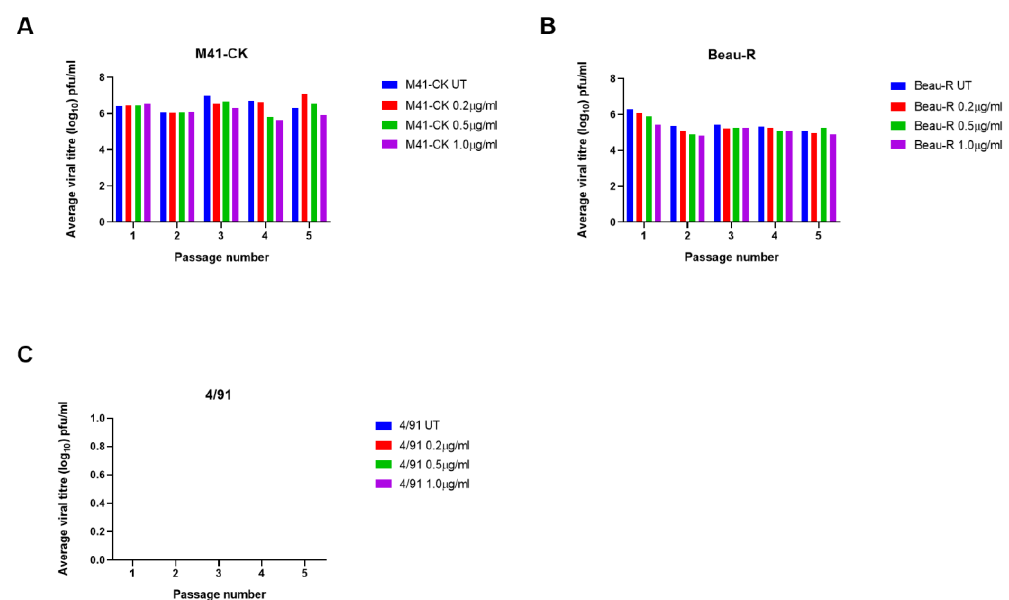
Figure 6. IBV replication is not affected by trypsin cleavage in CK cells. Three strains of IBV were passaged in the presence of TPCK-treated trypsin at three concentrations, 0.2, 0.5 and 1.0 µg/mL, alongside untreated (UT) samples of each strain. Cells were infected with each IBV diluted at a ratio of 1:1 in serum free BES media containing each concentration of TPCK-treated trypsin. Supernatant was harvested at 48 hpi and used for the subsequent passage following the same protocol. Supernatant from each passage was titrated on CK cells in triplicate and viral titres were calculated (pfu/mL). The average viral titre at each passage is shown for M41-CK ( A ), Beau-R ( B ) and 4/91 ( C ).